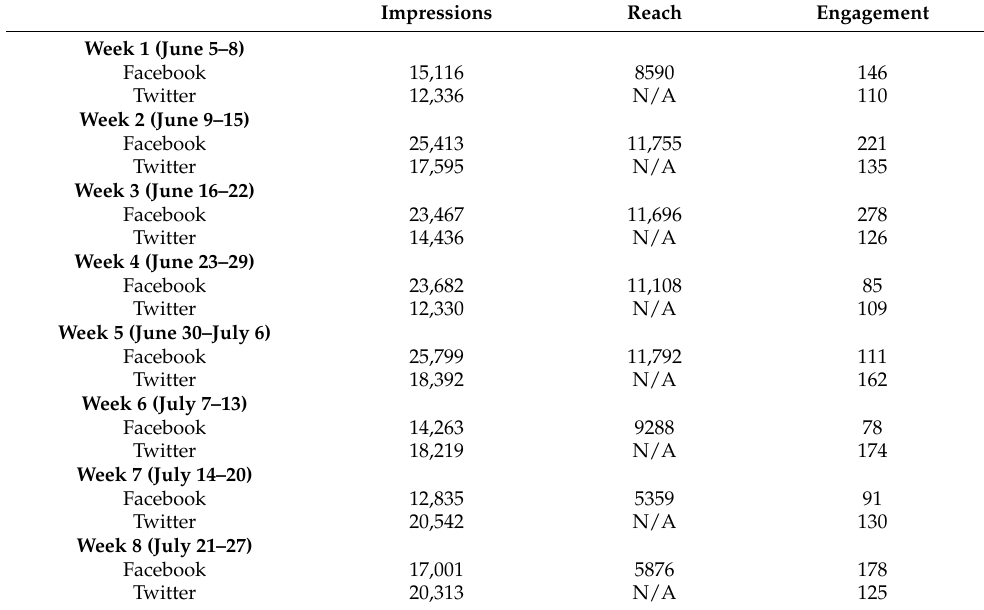
Table 2. Digital media performance by